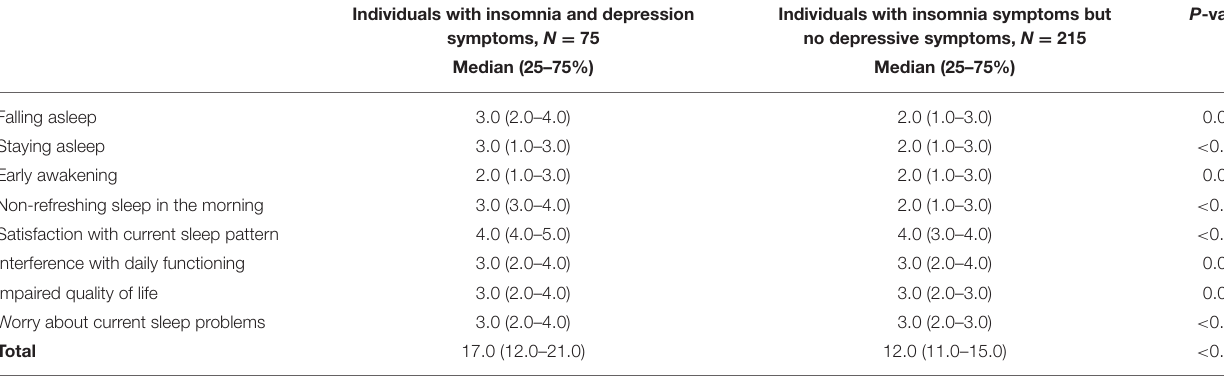
TABLE 3 | Total and item scores of the ISI among individuals with insomnia symptoms according to the presence of depressive symptoms. P -value* Individuals with insomnia and depression Individuals with insomnia symptoms but symptoms, N = 75 no depressive symptoms, N = 215 Median (25–75%) Median